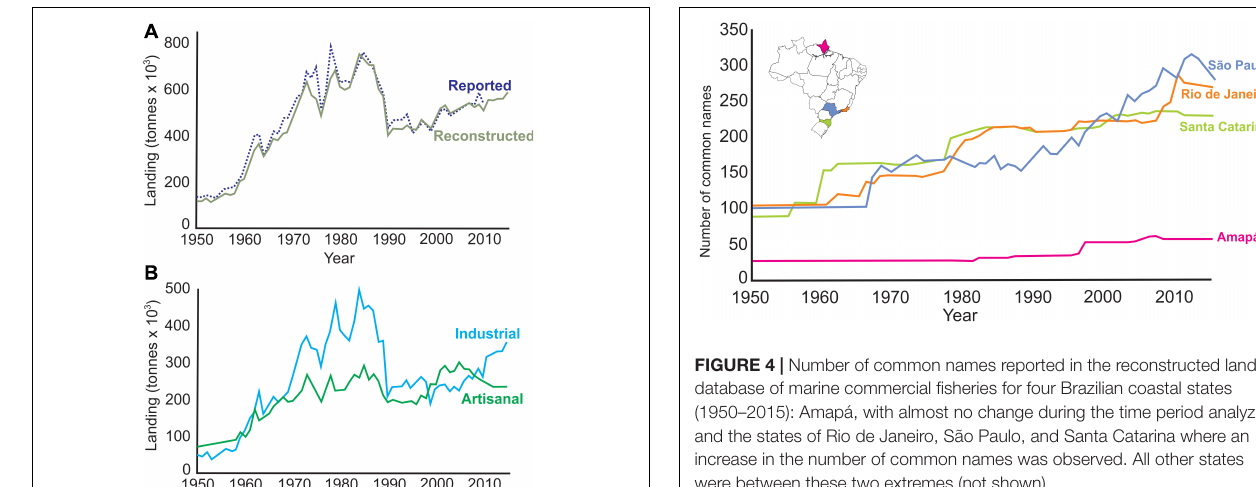
Moritz and Bartz-Beielstein, 2017) and loess already included in